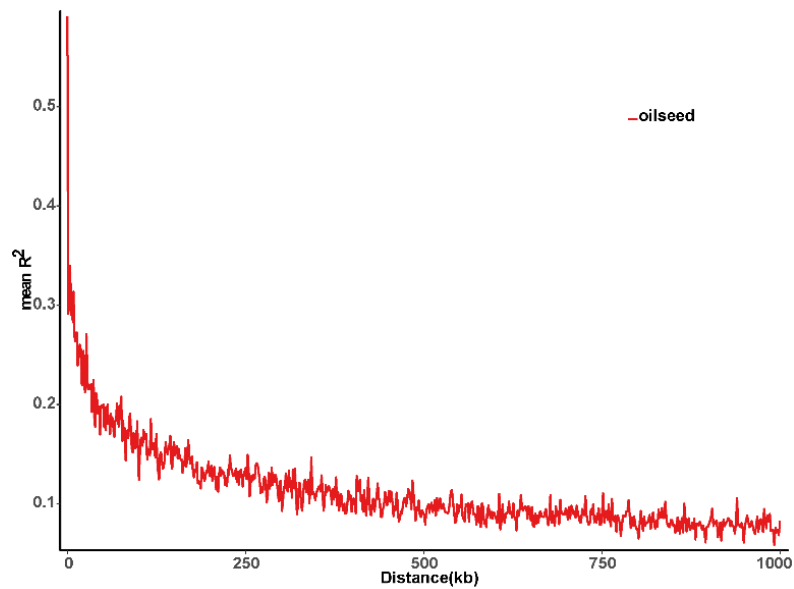
Figure 2. The linkage disequilibrium (LD) decay for the 146 rapeseed accessions.